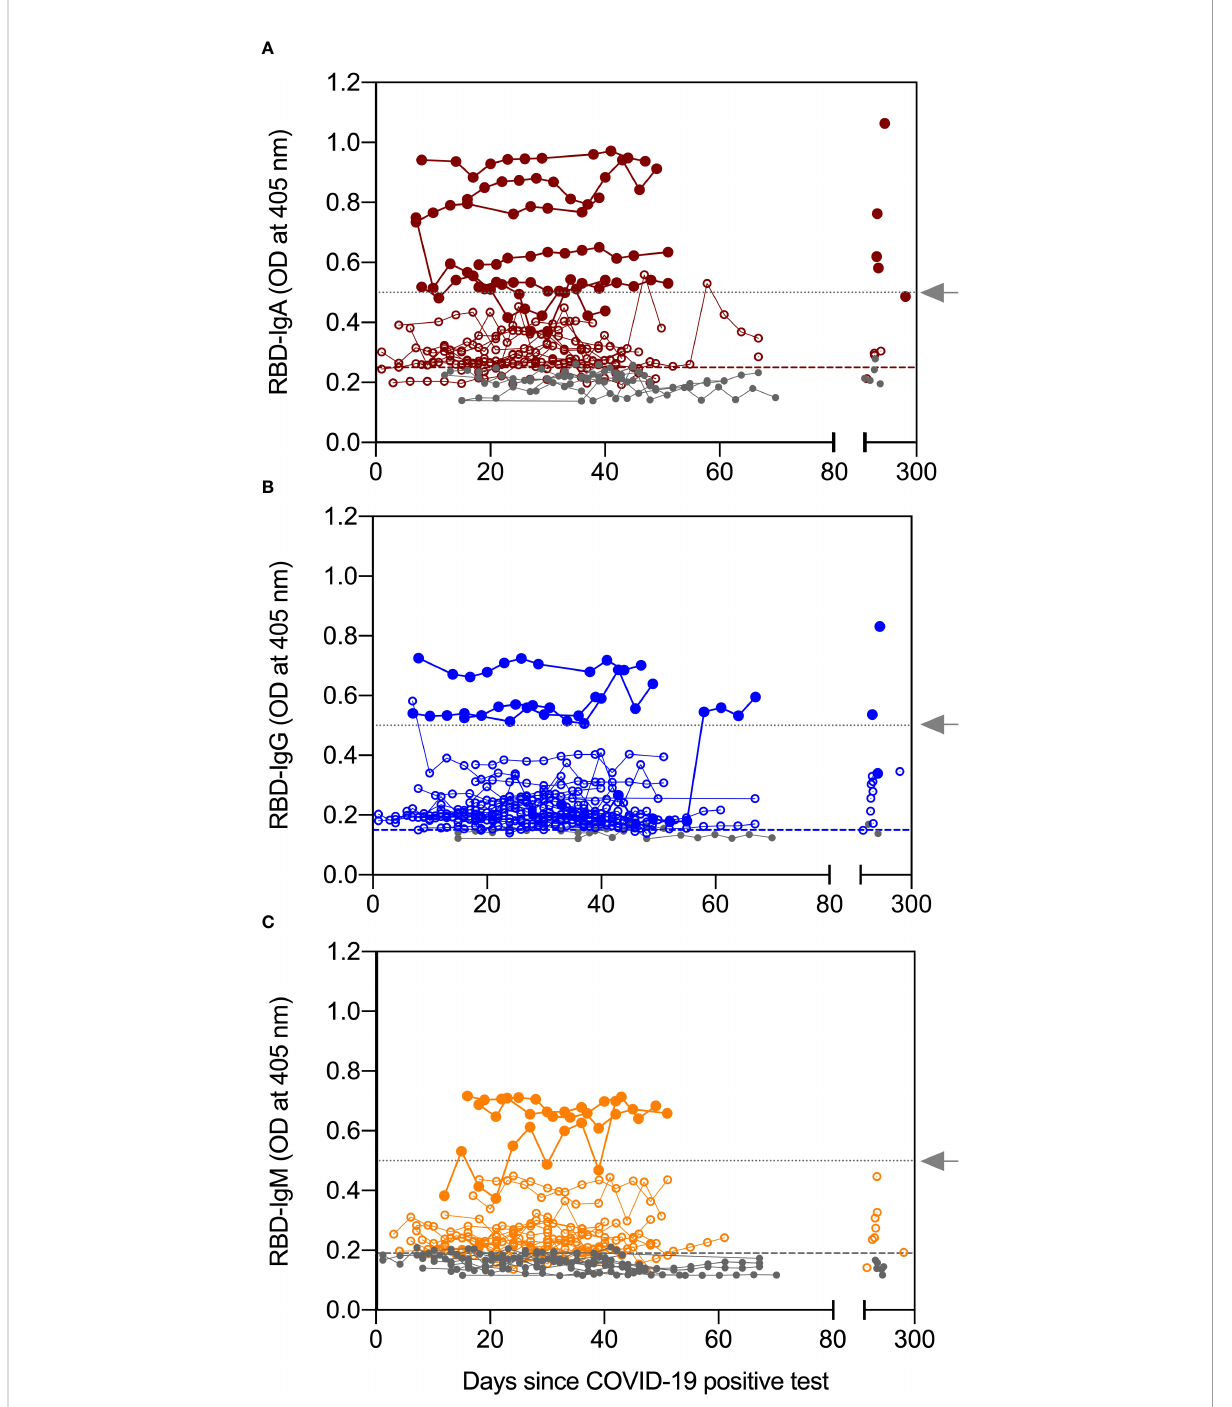
FIGURE 2 Antibody levels in serial milk samples after SARS-CoV-2 infection. Serial milk samples were obtained across 34 days after a woman enrolled in the study, which was within 21 days of her symptoms and positive COVID-19 PCR test (except for 2 women, see text for details). A fi nal sample was obtained ≥ 120 days after the initial milk sample. The X axis shows the sample collection for all 30 women relative to their positive COVID- 19 PCR test; day 0 indicates day of positive COVID-19 test. Whey fractions were assessed with ELISA for receptor binding domain (RBD)-speci fi c immunoglobulin (Ig)A (A) , IgG (B) , and IgM (C) . Horizontal dashed lines indicate the positive cut off values and horizontal dotted lines (grey arrow) indicate an OD of 0.5. Levels greater than 0.5 OD are grouped into high